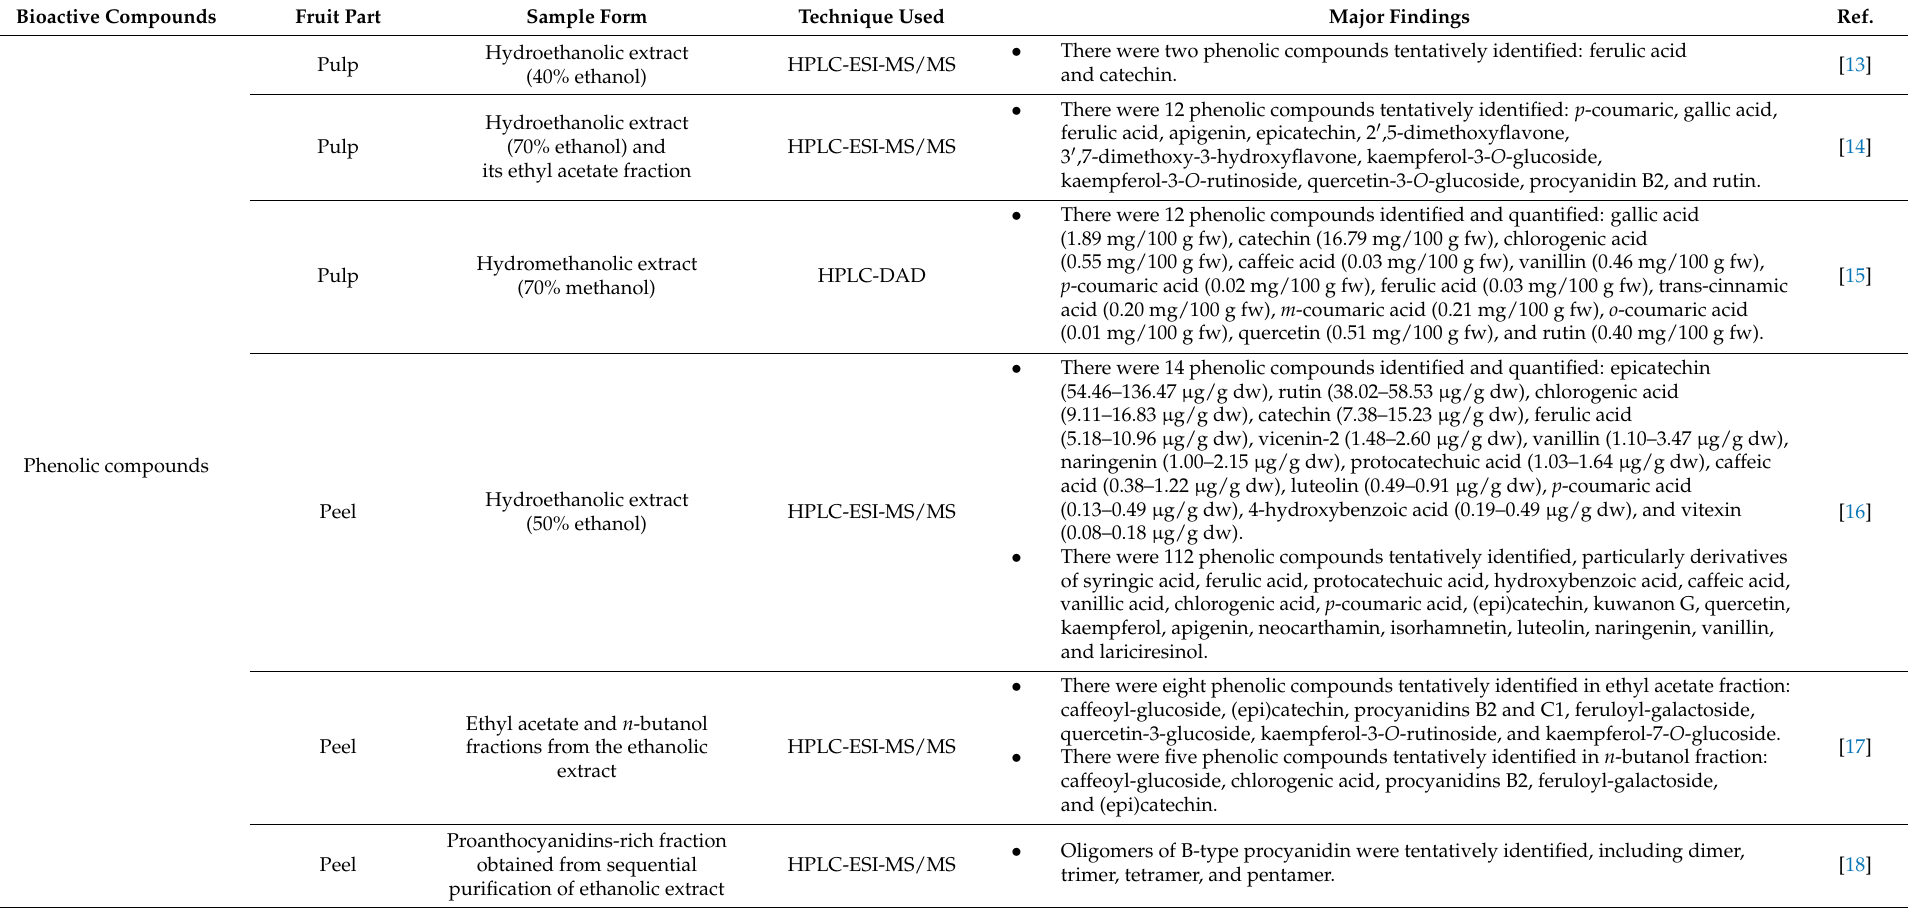
Table 1. A summary of studies showing the bioactive compounds found in araticum